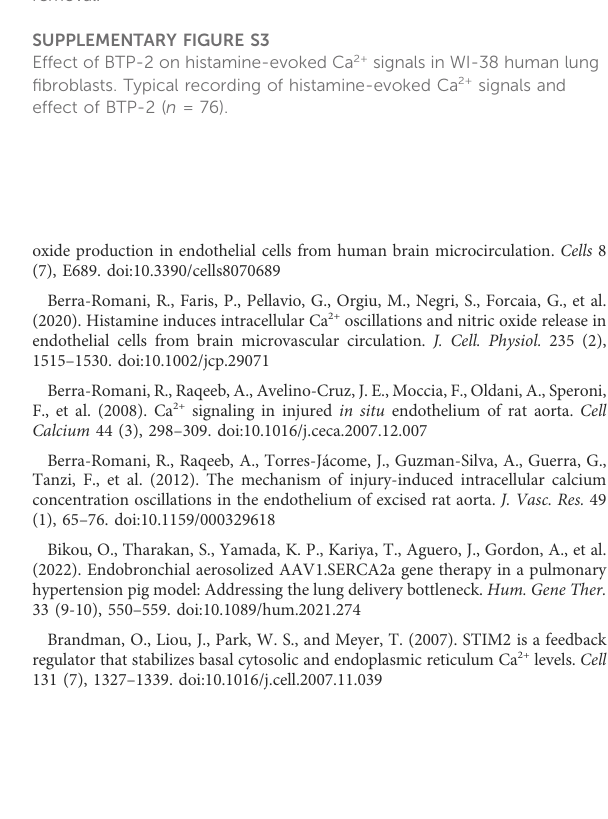
SUPPLEMENTARY FIGURE S1 Effect ofcaffeine on histamine-evoked Ca 2+ signals in WI-38 human lung fi broblasts. Typical recording of histamine-evoked Ca 2+ signals and effect of the application of 10 mM caffeine. SUPPLEMENTARY FIGURE S2 Effect of extracellular Ca 2+ removal on histamine-evoked Ca 2+ oscillations in WI-38 human lung fi broblasts. Typical recording of histamine-evoked Ca 2+ oscillations and effect of extracellular Ca 2+